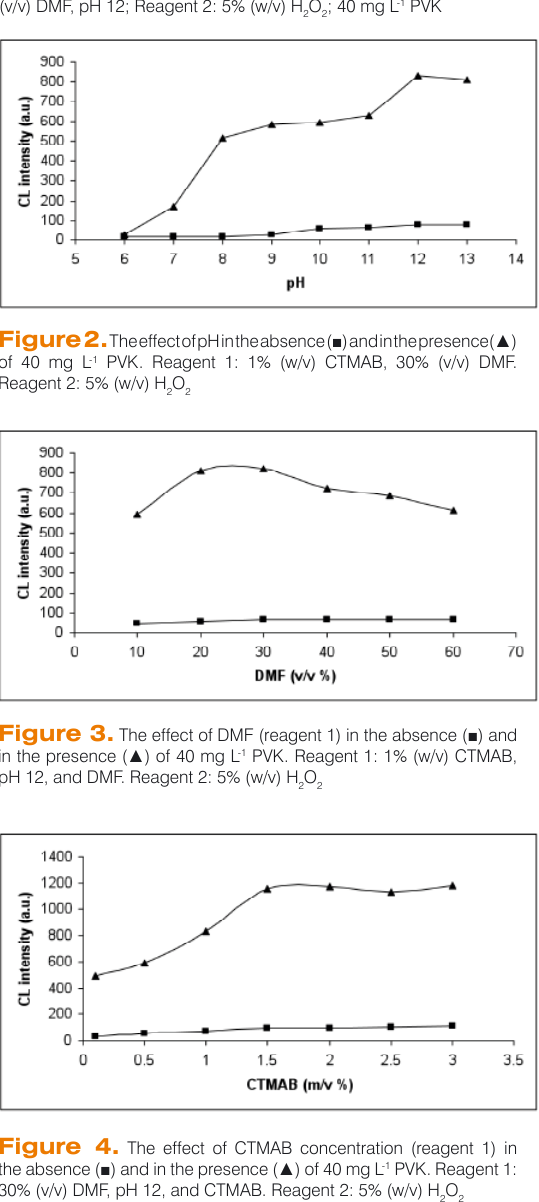
O ; 40 mg L -1 PVK 2 2